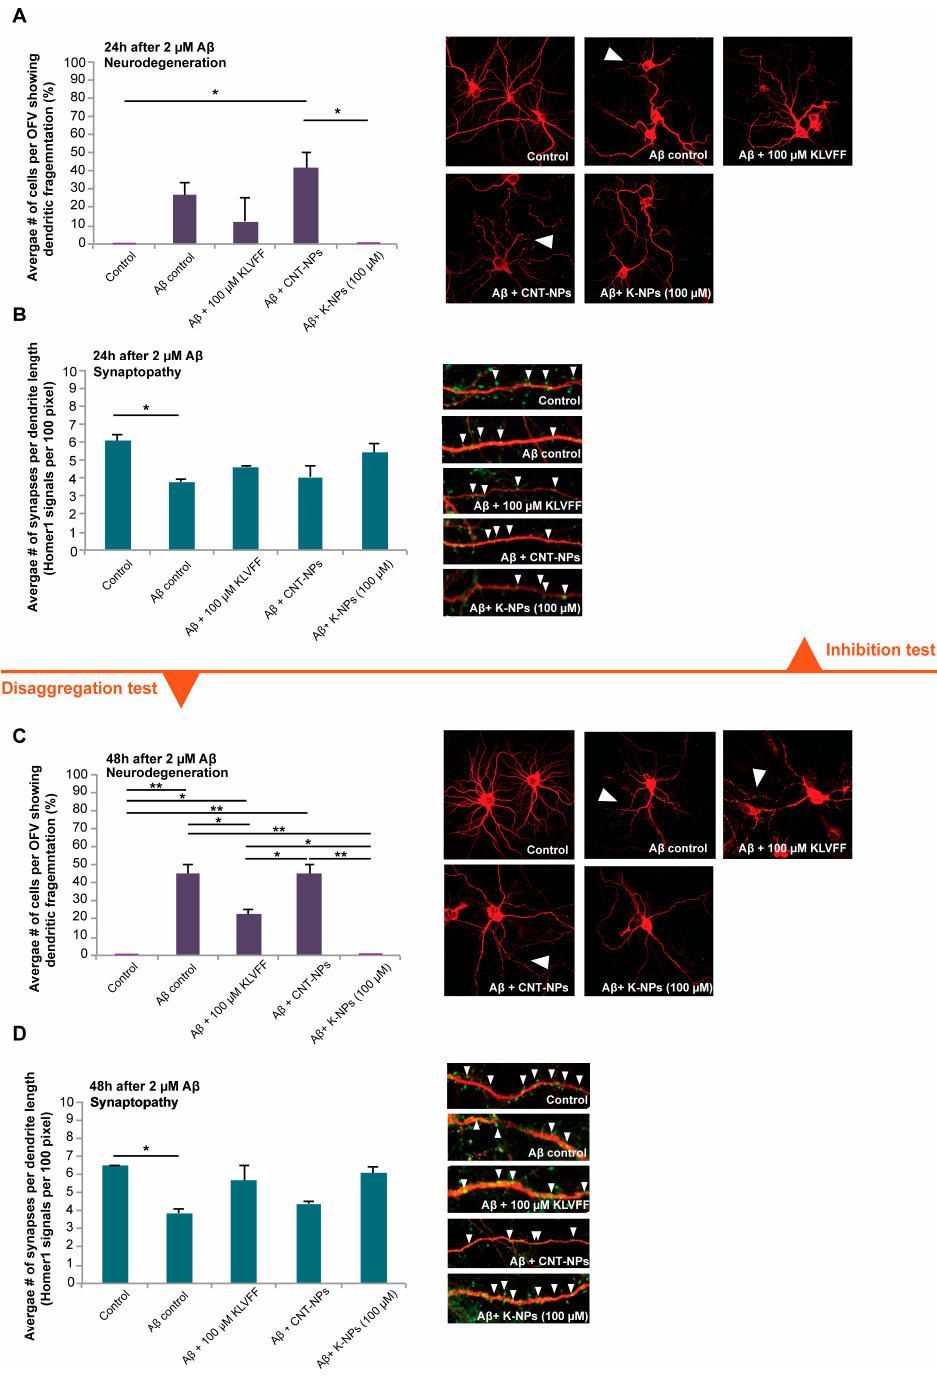
Figure 5. Neurons were treated for either 24 h ( A , B ) or 48 h ( C , D ) with 2 µ M A β (1–42) , and dendritic fragmentation ( A , C ) and synapse density ( B , D ) were evaluated by MAP2 staining and by measuring the number of Homer1 positive signals per dendrite length from three optic fields of view (OFV) with at least 10 cells 24 h after addition of 100 µ M KLVFF peptides, CNT-NPs, or NPs delivering the equivalent of 100 µ M KLVFF. Images show MAP2 (red) and Homer1 (green). Exemplary synapses are labeled with arrows. A more detailed caption with the relevant statistical analysis data is reported in the supplementary